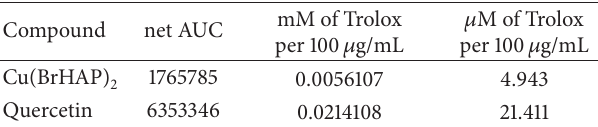
on the proliferation of Table 2: Antioxidant capacity of the compound was determined by 2 the ORAC for 24, 48, and 72 h. The IC values 2 50